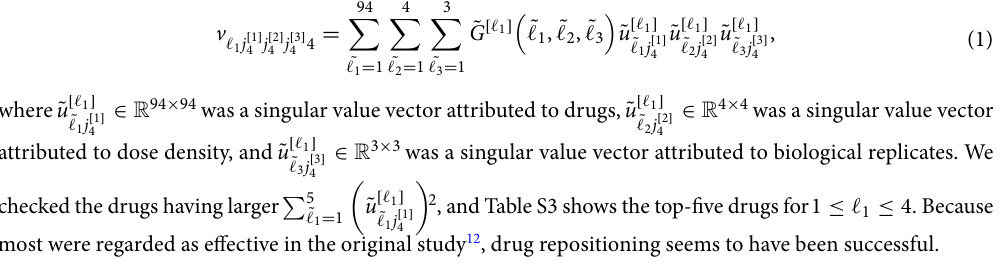
were coincident with classification. [ 1 ] [ 2 ] [ 3 ] 1 j 5 j 5 j 5 5